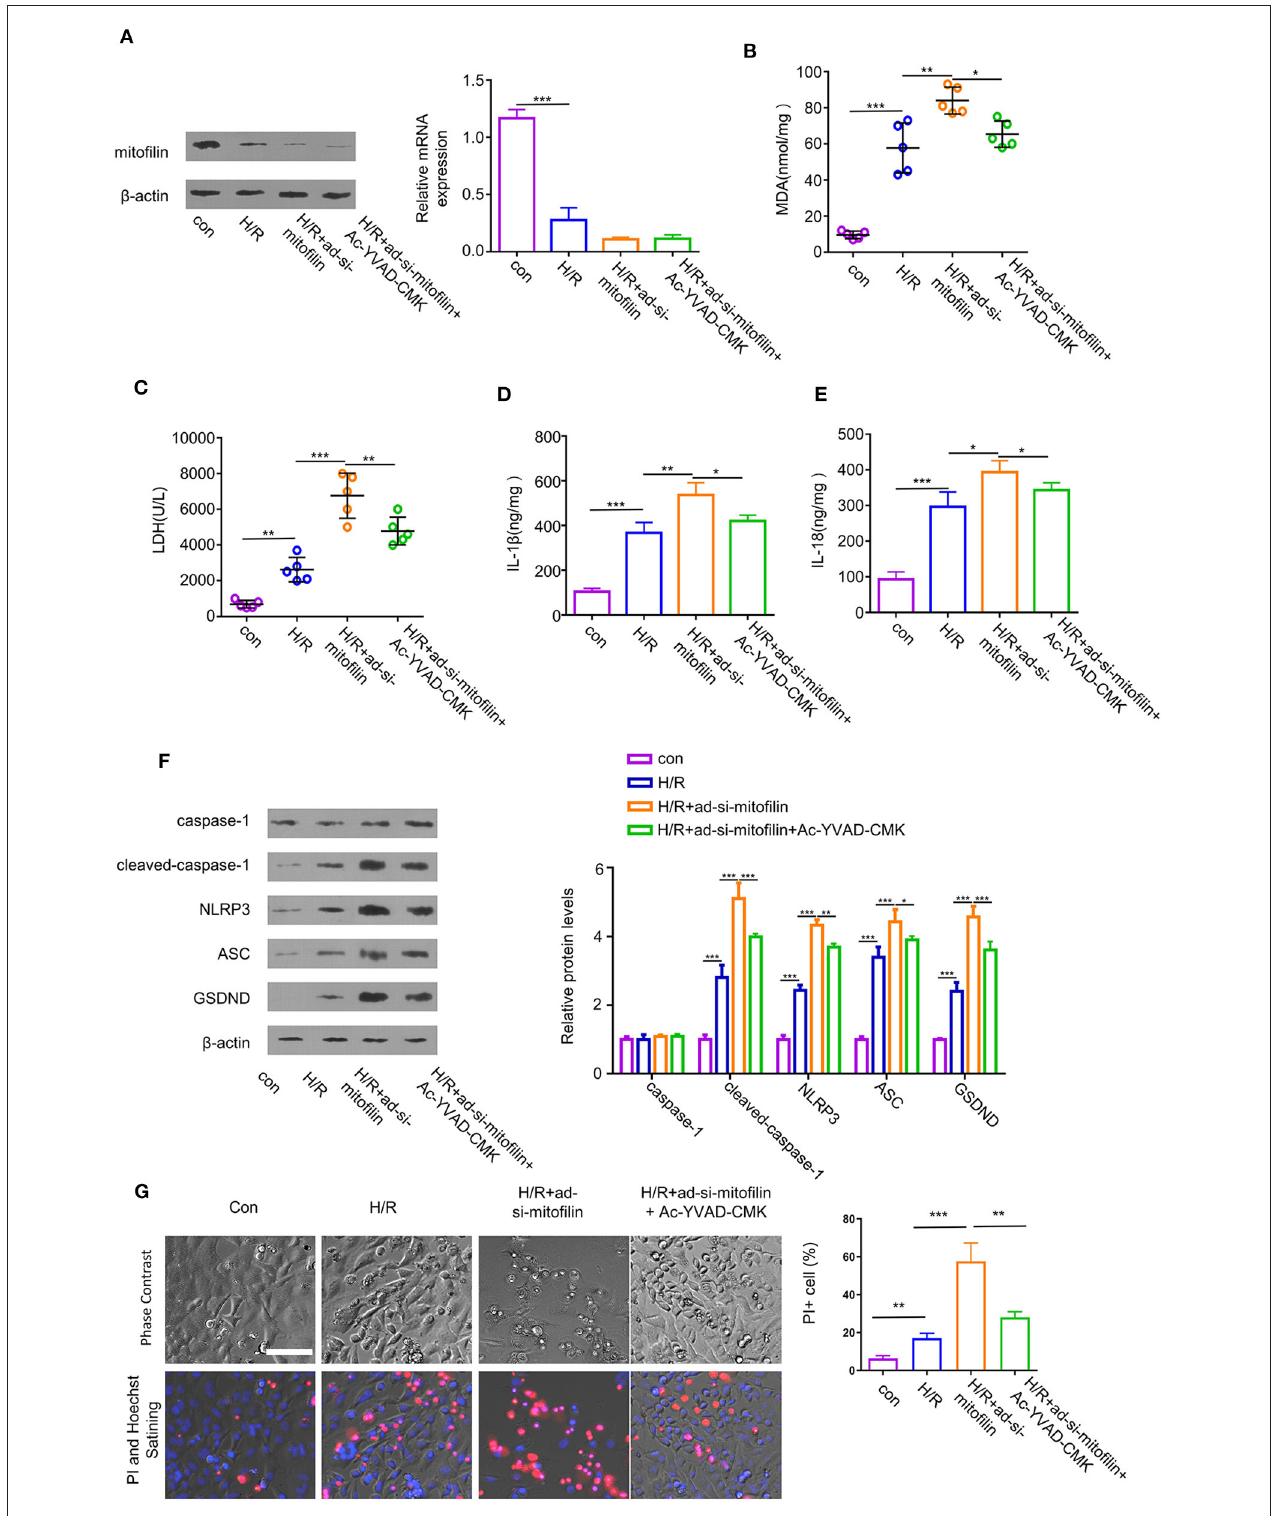
FIGURE 3 | Mitofilin knockdown exacerbates hypoxia/reoxygenation (H/R)-induced cell damage of H9C2 by regulating pyroptosis. (A) The expression level of mitofilin was strongly reduced after the administration of ad-si-mitofilin. (B,C) H/R induced the increase of MDA level and LDH level in H9C2 cells, while levels were